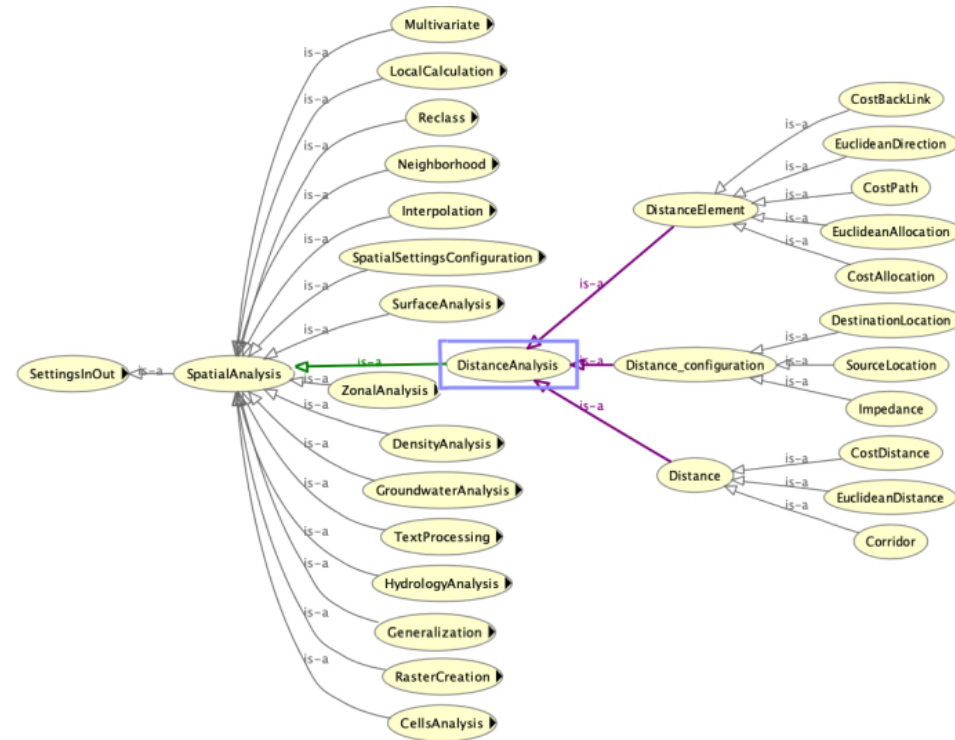
Figure 8. Extract from the data ontology for the R1 request example.